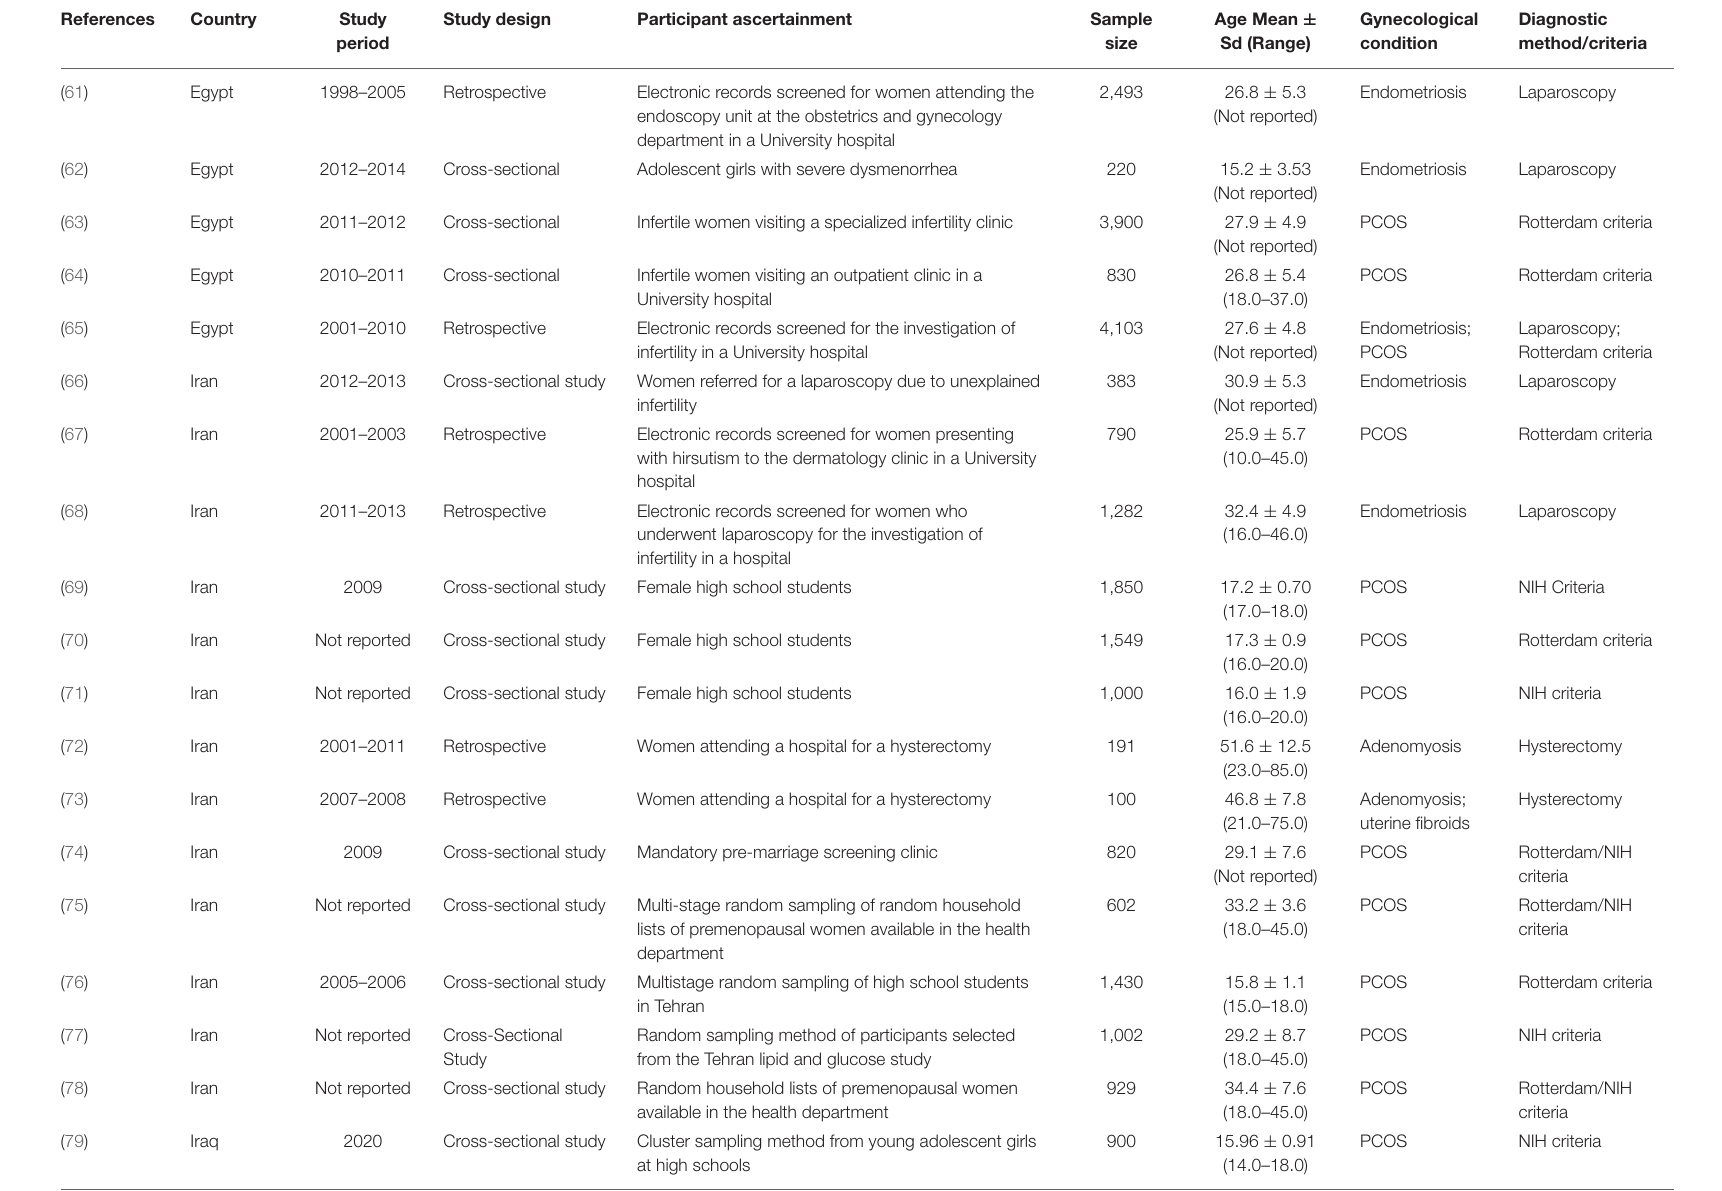
TABLE 2 | Characteristics of the 47 studies included in the